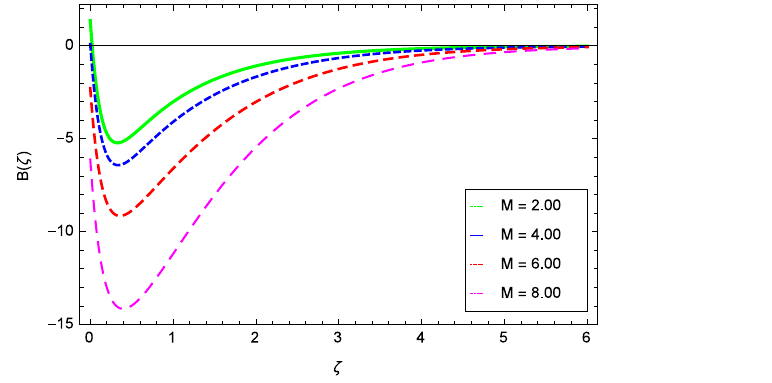
Figure 4. Effect of M on axial velocity B (ζ) .